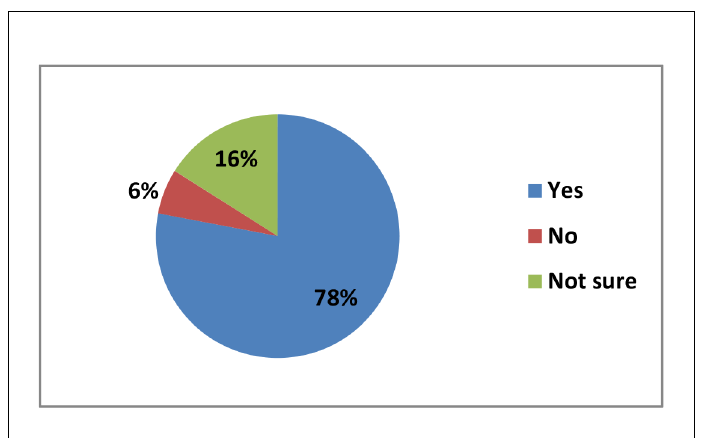
Figure 5. Proportion of responders that thought language affected the treatment process